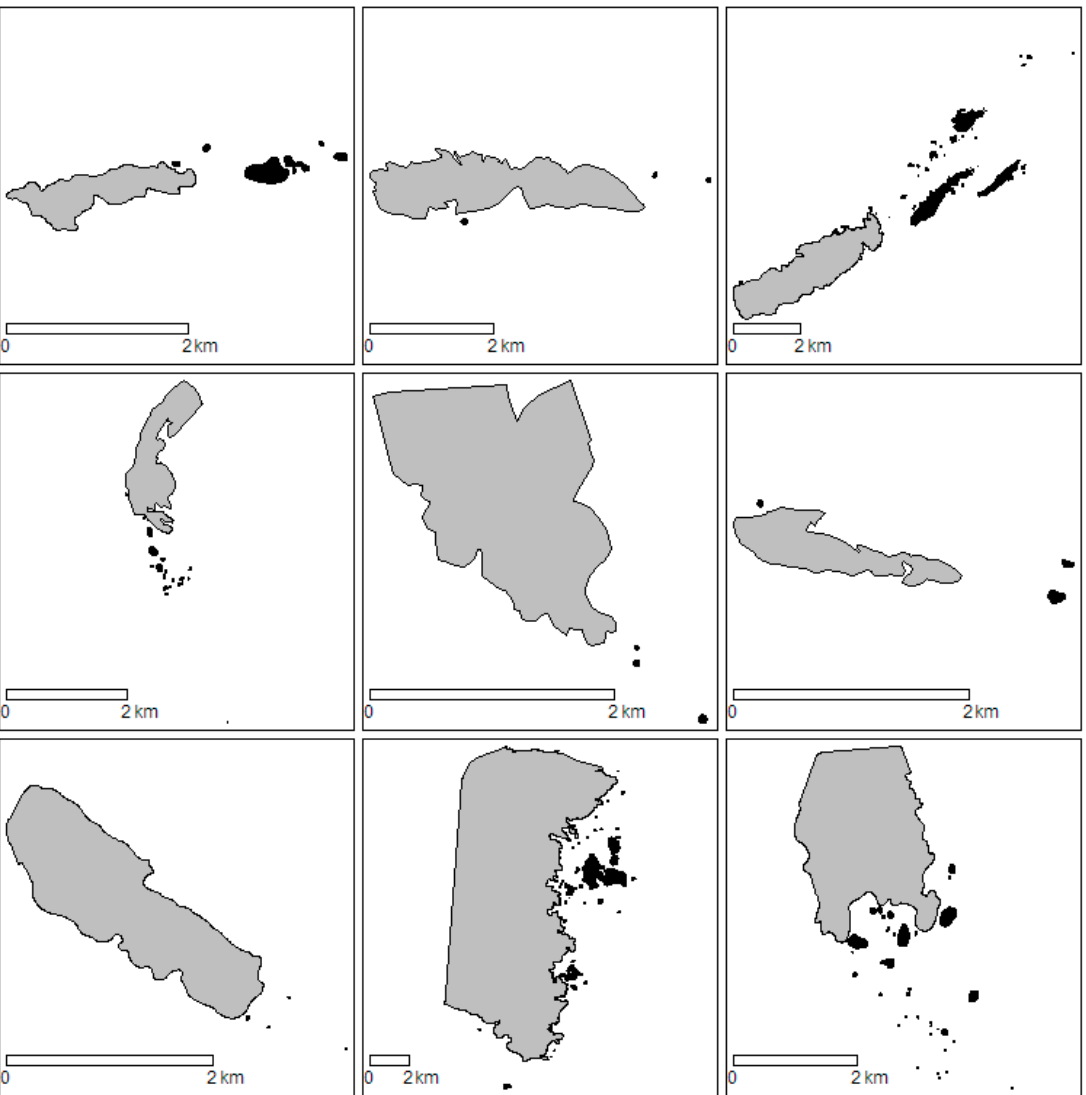
Figure A3. The nine other-distribution fires with the longest maximum spotting distances. Source fire is in grey, spot fires are in black.